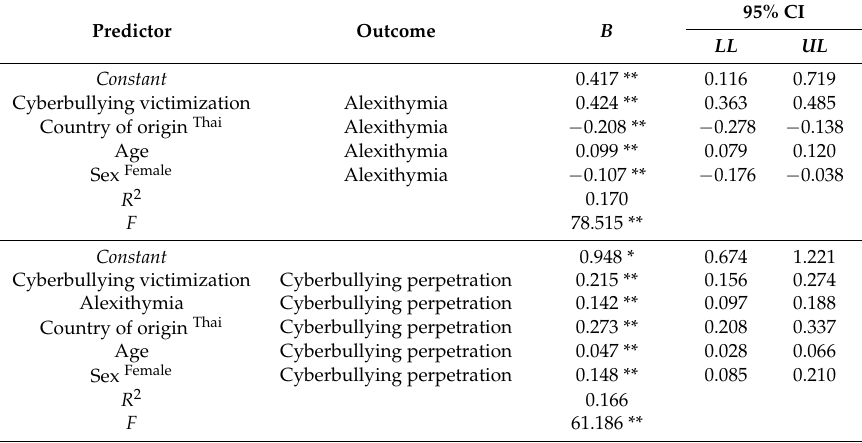
Table 2. Mediation analysis of cyberbullying victimization on perpetration via alexithymia.